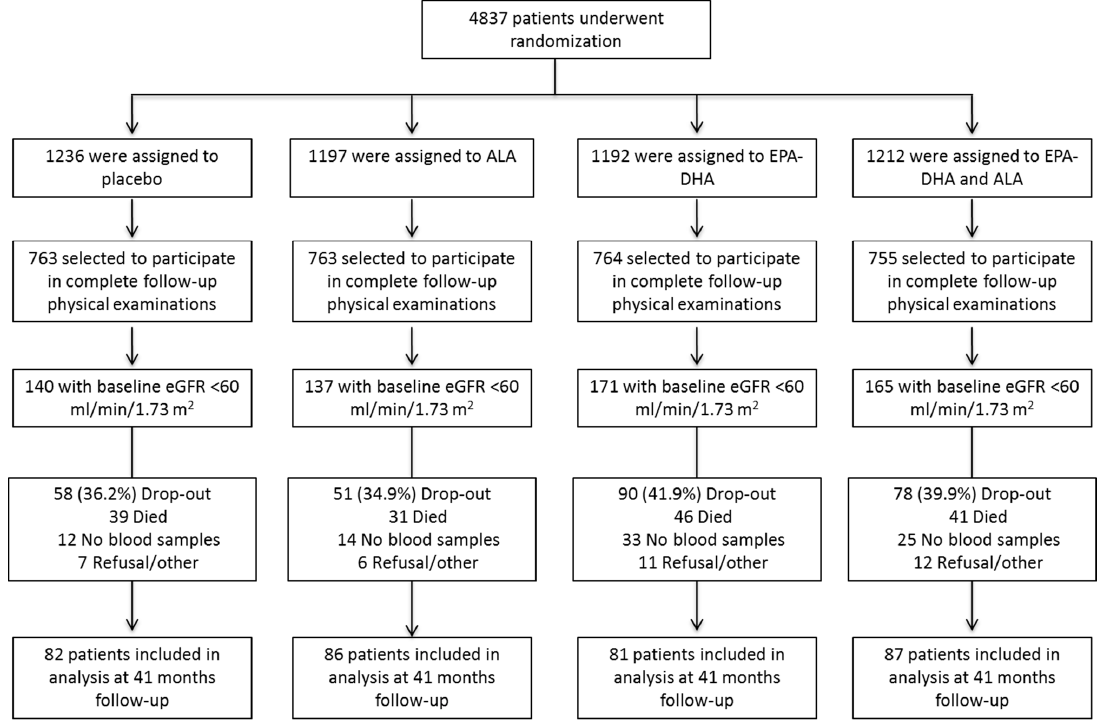
Figure 1. Flowchart of the FGF23 biomarker study within the Alpha Omega Trial. Participant flow for the study on the effect of n-3 fatty acid supplementation on plasma C-terminal FGF23 levels in post myocardial infarction patients in the Alpha Omega Trial with chronic kidney disease stage 3(eGFR < 60 mL/min/1.73 m 2 ).